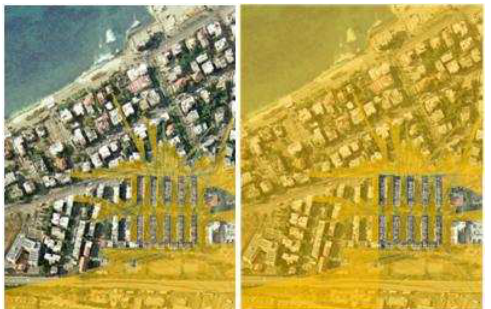
Figure 8. Comparing Visual openness. On the left regarding the existing state. On the right regarding utilized roofs